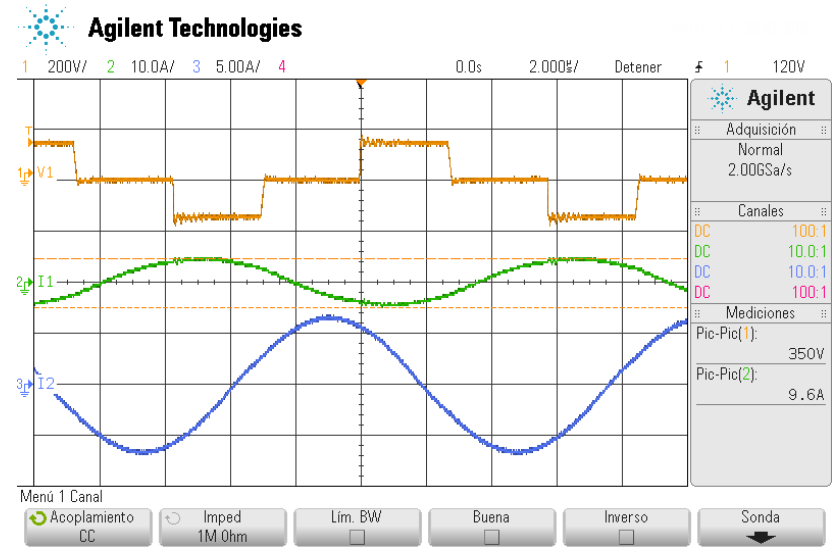
Figure 19. Currents through the compensated magnetic coupler: primary side current i 1 (green), secondary side current i 2 (blue). Output voltage of the H-bridge converter